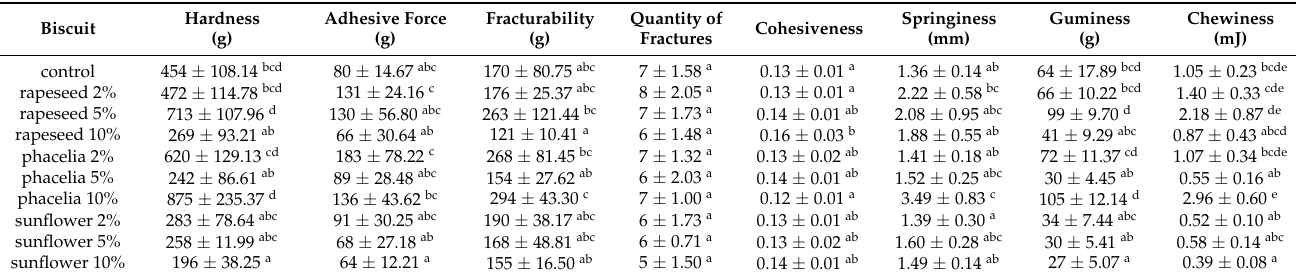
Table 7. Texture properties of